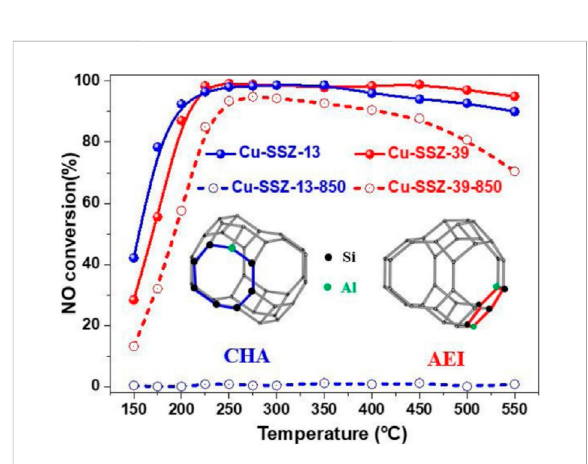
FIGURE 7 Comparison of NH 3 -SCR performance of Cu-SSZ-13 and Cu-SSZ-39 after high temperature hydrothermal treatment at 850 ° C (Shan et al.,